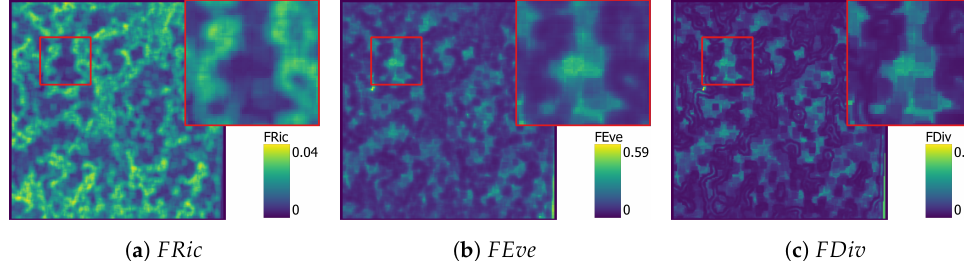
Figure 7. KDE functional diversity maps with FRic , FEve , and FDiv in their own figure.